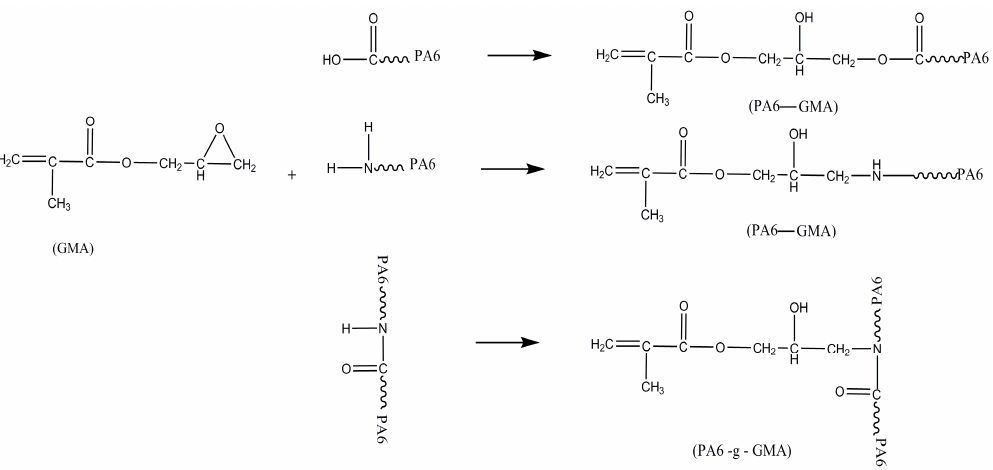
Scheme 1. Schematics of the ring opening reaction occurring between the GMA and PA6 during melt